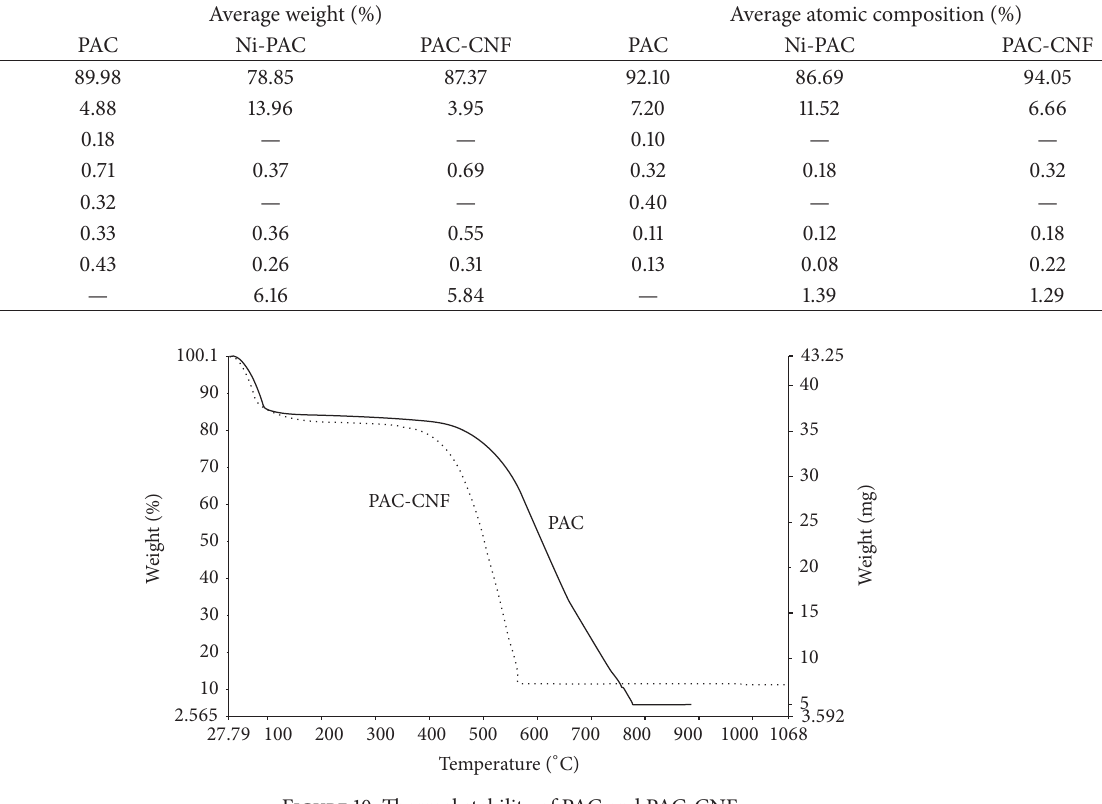
Figure 10: Thermal stability of PAC and